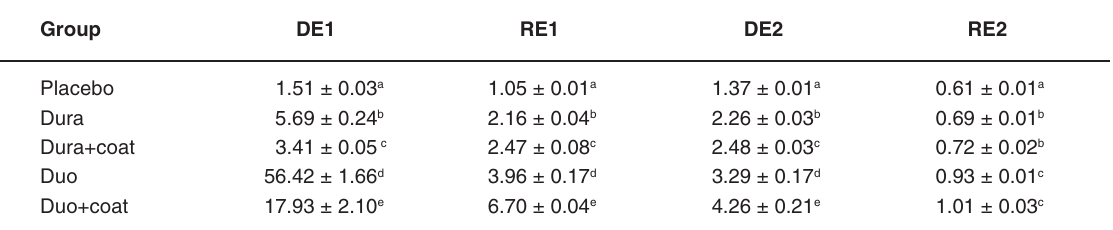
Means followed by different letters indicate statistically significant difference between the groups (Kruskal-Wallis,